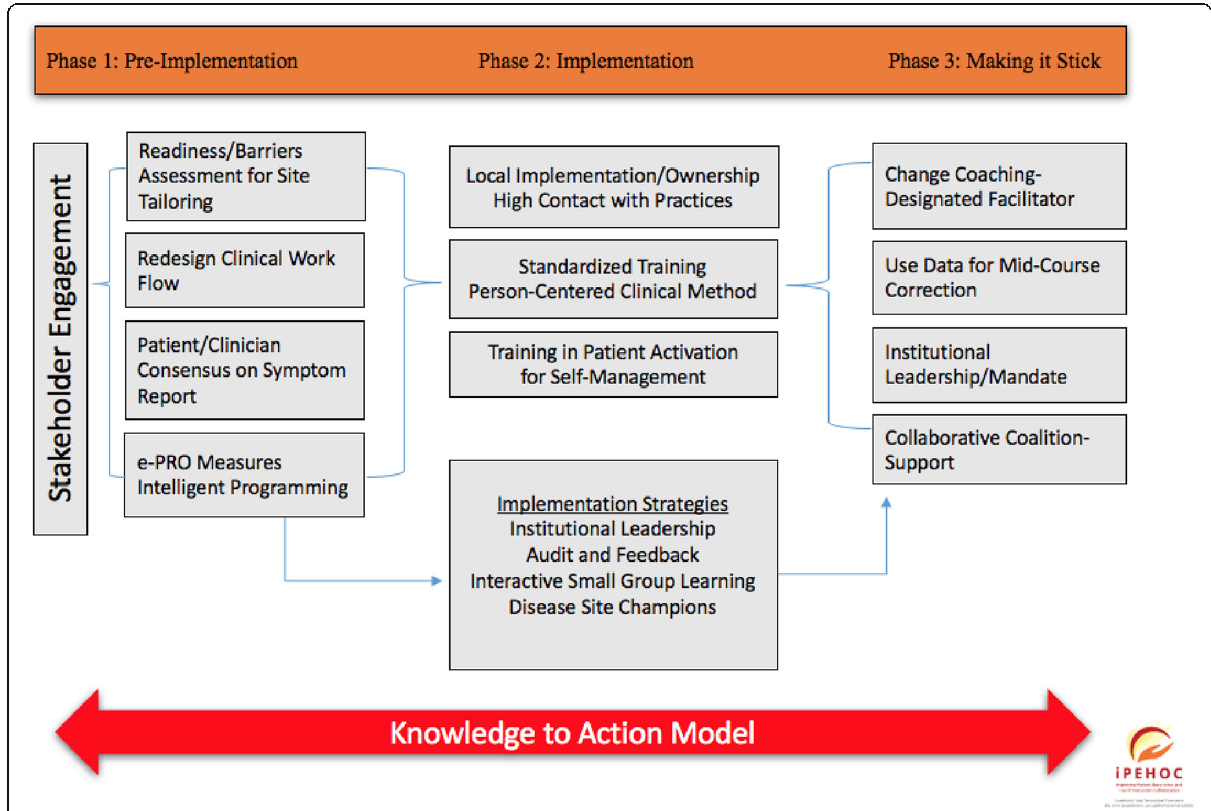
Fig. 1 iPEHOC Phases of Implementation and Key